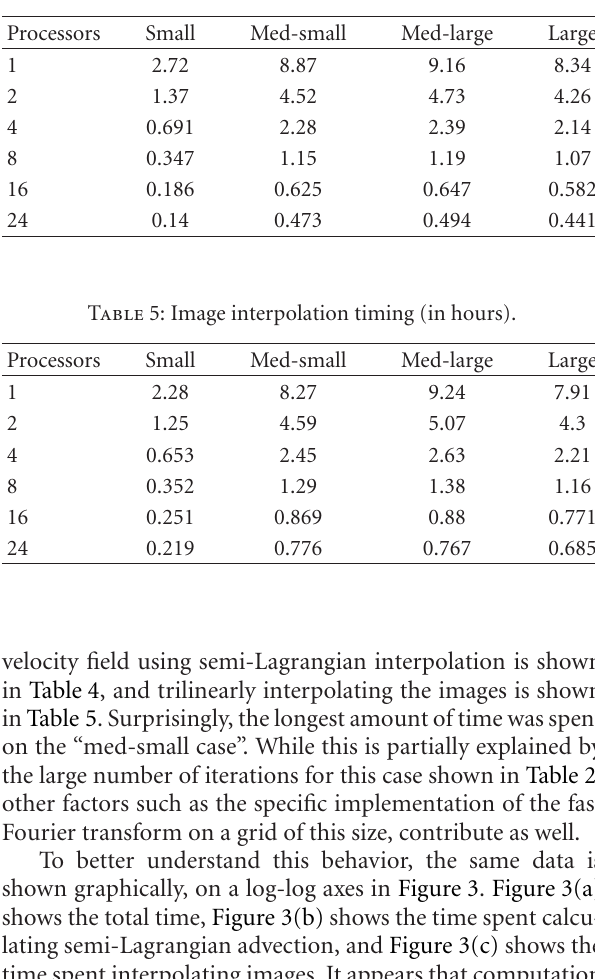
Table 4: Semi-Lagrangian timing (in hours).